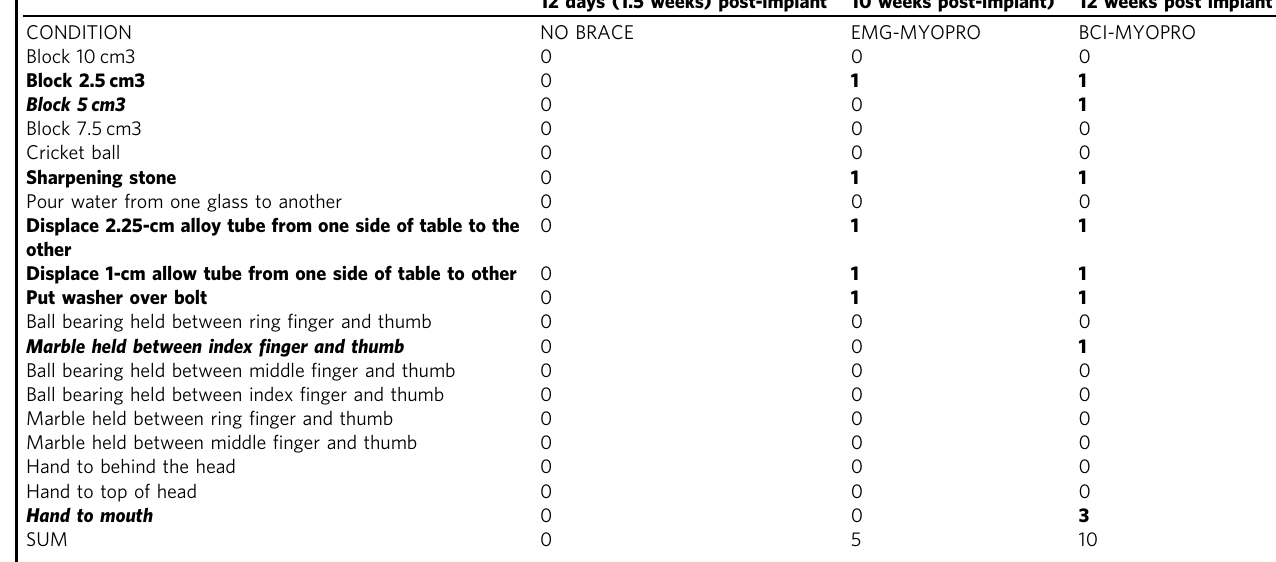
Table 1 Arm Research Action Test.